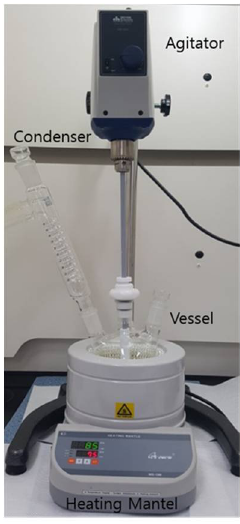
Figure 2. Leaching reactor used for leaching indium-tin-oxide from the crushed glass cullet.